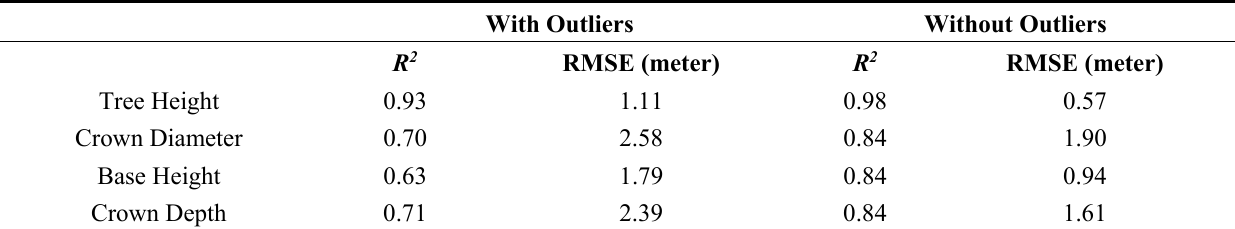
Table 2. Summary statistics of field-measured vs. LiDAR-estimated tree height, crown diameter, base height, and crown depth. Field (meter) LiDAR (meter) Max. Min. Mean Std. Max. Min. Mean Std. Tree Height 26.49 Crown Diameter